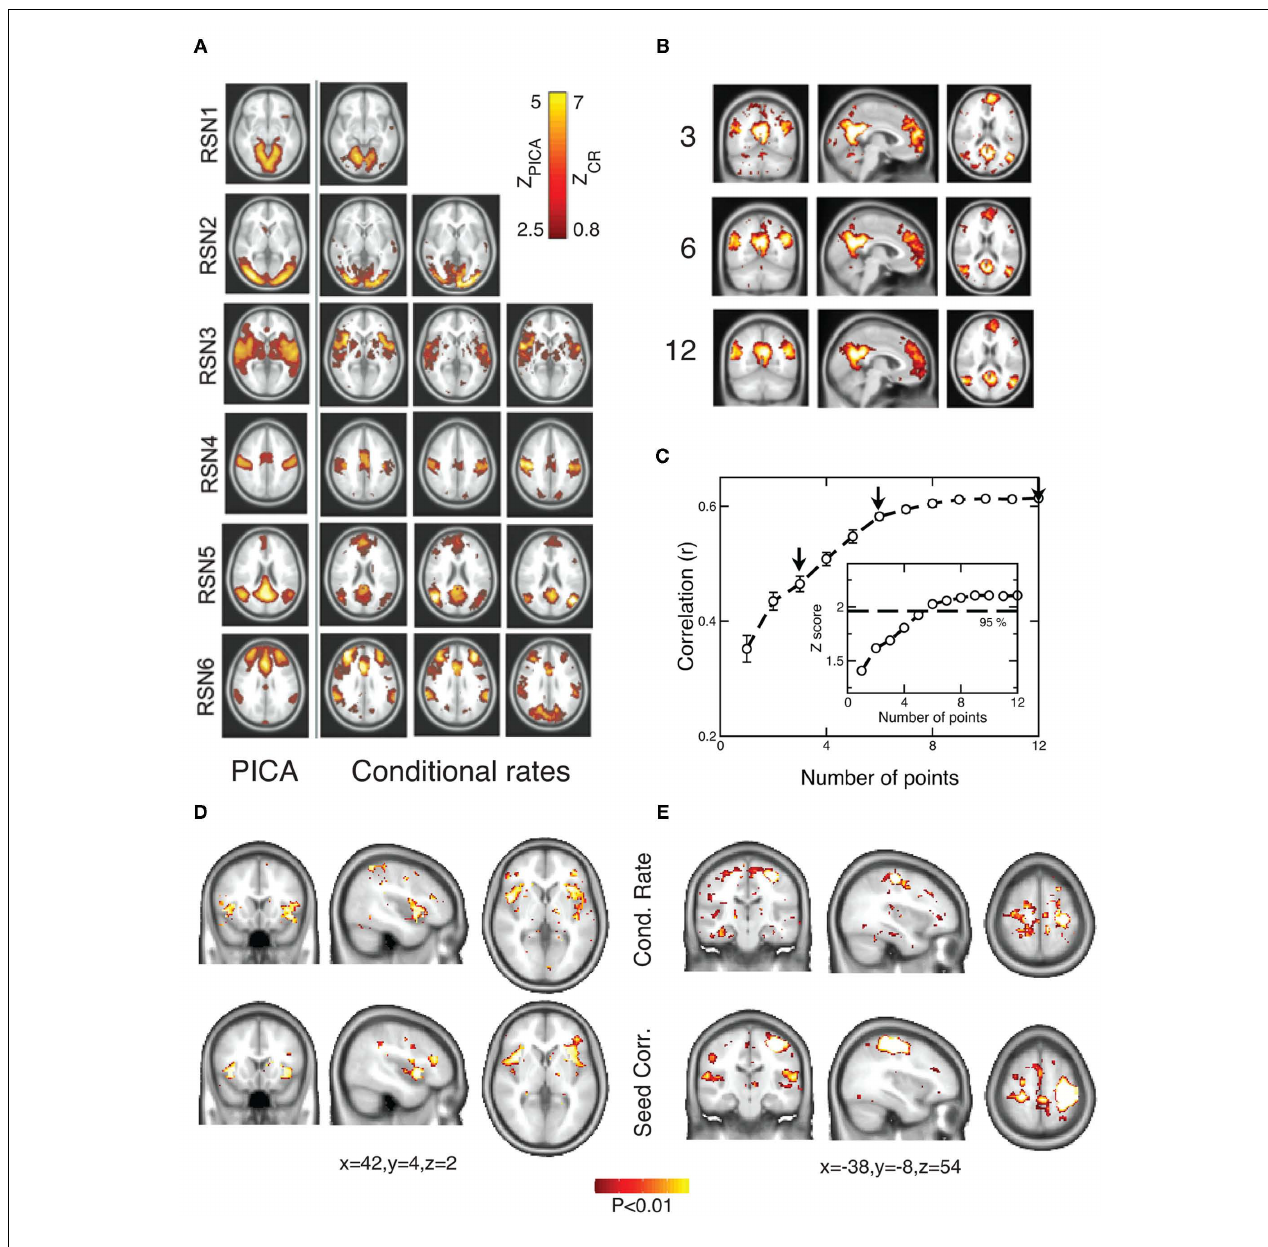
a function of the number of points used. Arrows denote the examples of (B) . Z scores (number of points as degrees of freedom) with the line of 95% confidence are plotted in the inset. (D) The point process is able to track the statistical differences between the functional connectivity maps of a group of chronic back pain patients and healthy controls already reported in (Tagliazucchi et al., 2010a).The conditional rate of points (top) reproduces well the standard seed correlation approach (bottom) derived from the same data. (E) The functional connectivity maps during a finger tapping task constructed from the conditional rate of points (top) compare well with the seed correlation maps derived from the same data (Tagliazucchi et al.,